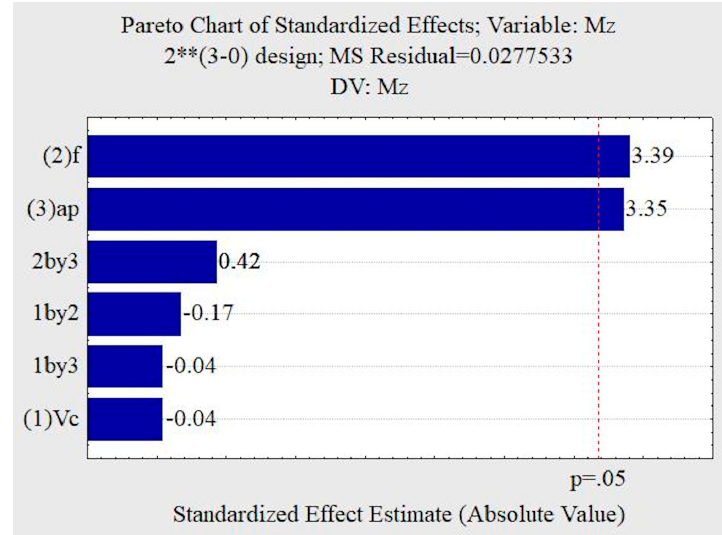
Figure 12. Pareto chart for the dry machining condition: torque M z .